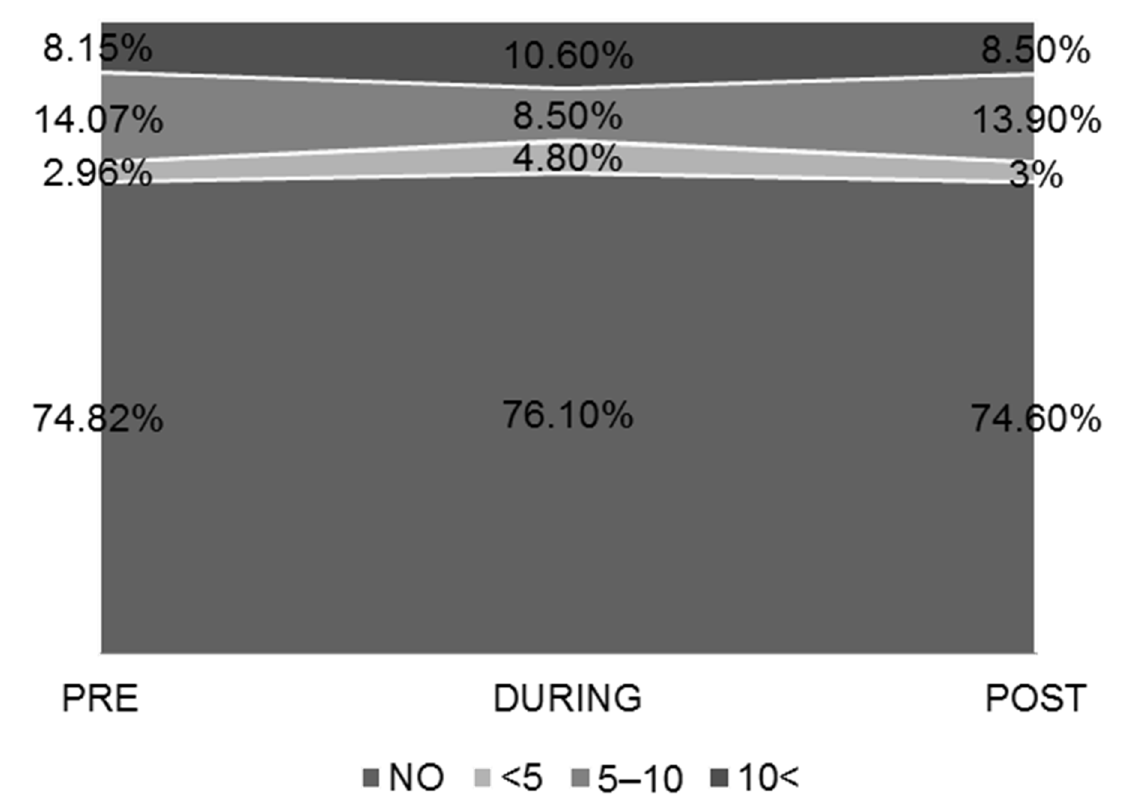
Figure 1. Smoking habits of the study population.